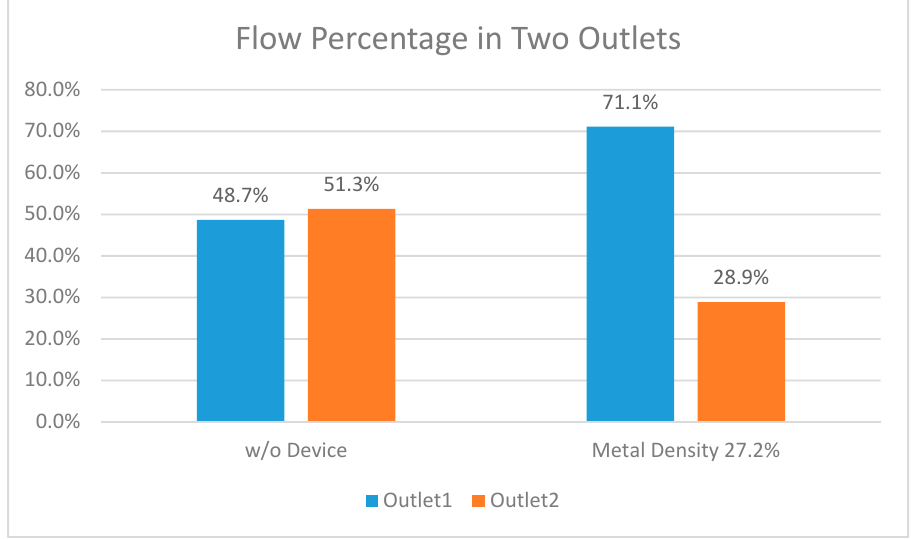
Figure 11. Fluid volume measurements at both outlets before vs. after occlusion.